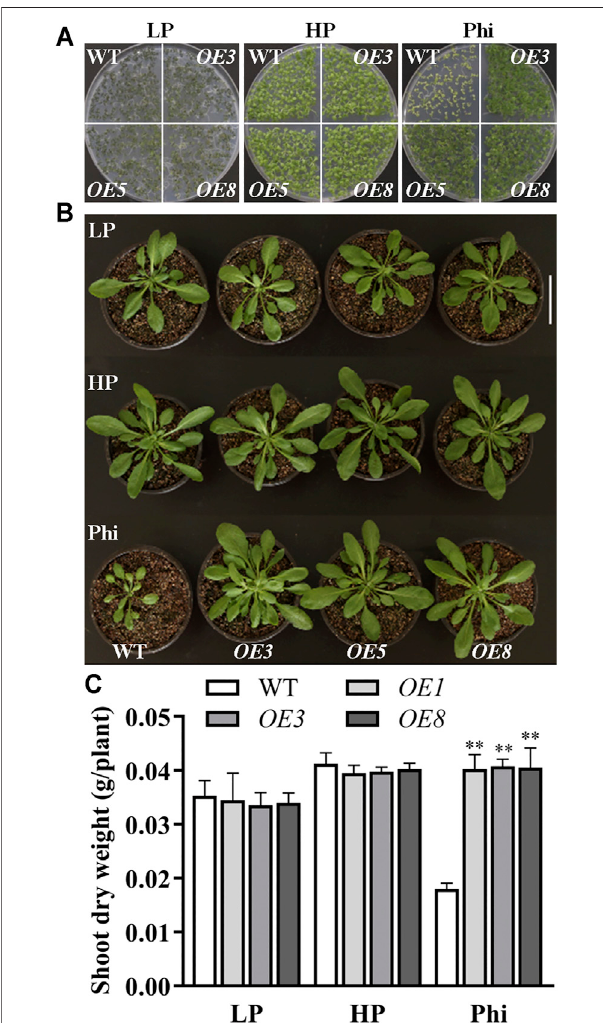
FIGURE2| Phenotypesof ptxD Q transgenic Arabidopsis withdifferentP sources. (A) Comparative growth of seedlings from ptxD Q overexpression lines ( OE3 , OE5 , and OE8 ) and WT ( Col-0 ) grown on MS plate medium containing 5 μ M phosphate (LP), 1.25 mM phosphate (HP), or 1.25 mM phosphite(Phi). (B) Transgenic and WT Arabidopsis were grown inasterilized mixture of sphagnum peat moss/perlite soil with MS solution containing 5 μ M phosphate (LP), 1.25 mM phosphate (HP), or 1.25 mM phosphite (Phi). Scale bar (cid:2) 5 cm. (C) Shoot dry weight of seedlings from WT and PtxD Q overexpression Arabidopsis grown in a sterilized mixture of sphagnum peat moss/perlite soil mix. The data are shown as means ± SD for four replicates. Asterisks indicate signi fi cant differences as compared with WT plants (Turkey ’ s test, ** p ≤ 0.01).